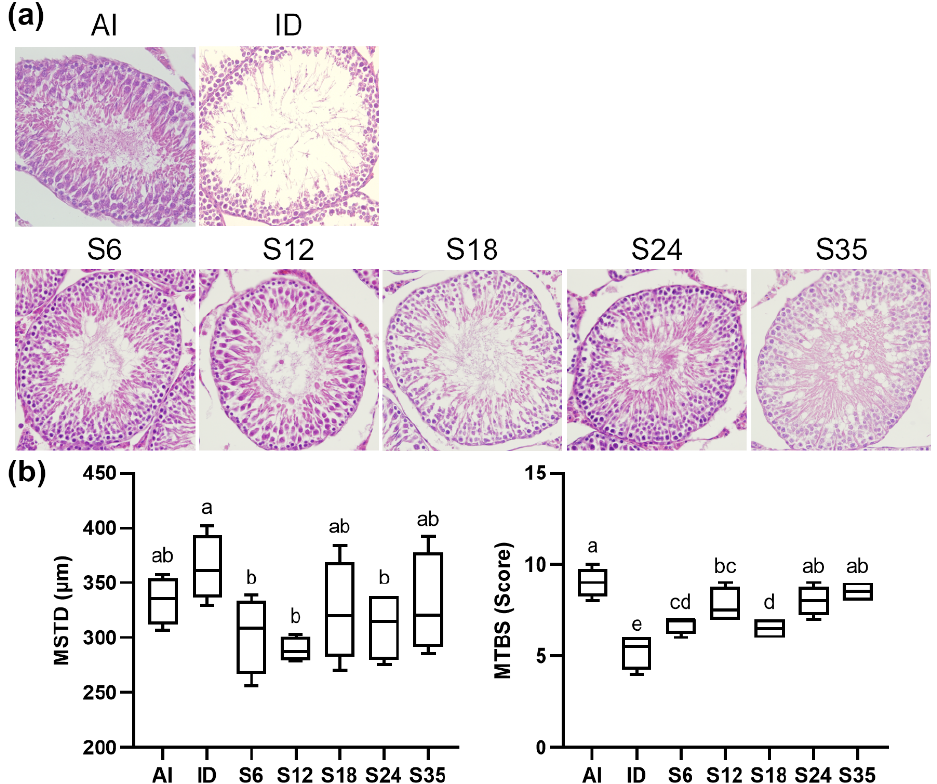
Figure 4. Effects of different doses of iron supplementation on ( a ) testicular histology by H&E staining and ( b ) mean seminiferous tubule diameter (MSTD) and mean testicular biopsy score (MTBS) in iron-deficient rats. Values are presented as median (interquartile range, IQR). n = 4 per group. Values not sharing the same letters are significantly different at p < 0.05.